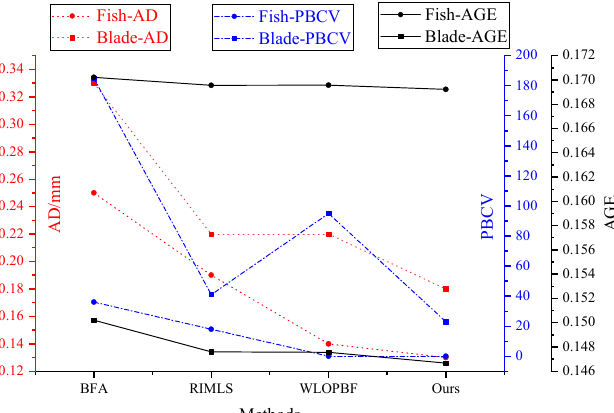
Figure 11. Small-scale noise filtering results.